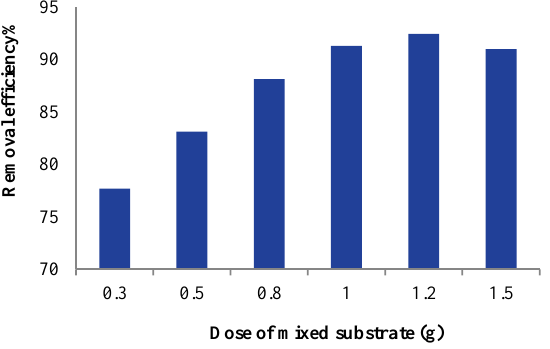
Figure 7. Effect of mixed substrate dose on removal efficiency [cyanide: 30 mg/l, pH: